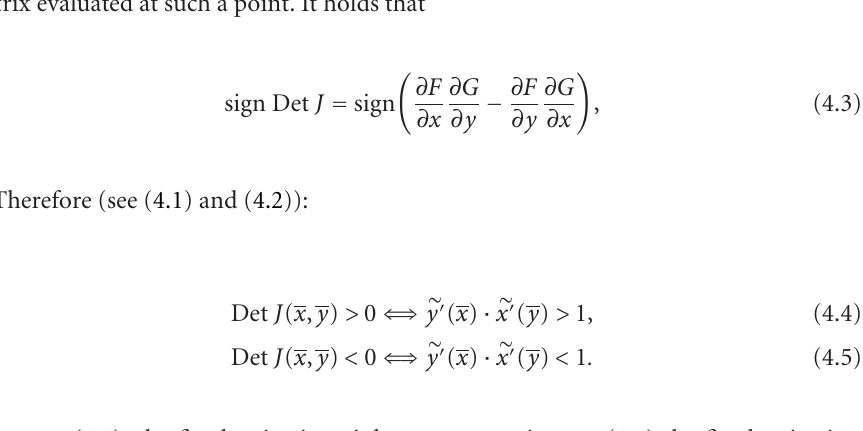
Figure 4.1 illustrates the previous theorem through a numerical example: the unique interior fixed point is a sink surrounded by a repelling limit cycle. In this figure, as in the following ones, the strip { 0 . 375 ≤ y ≤ 0 . 6 } , where the relevant topological features of the phase portrait occur, is zoomed with respect to the rest of the square [0,1] 2